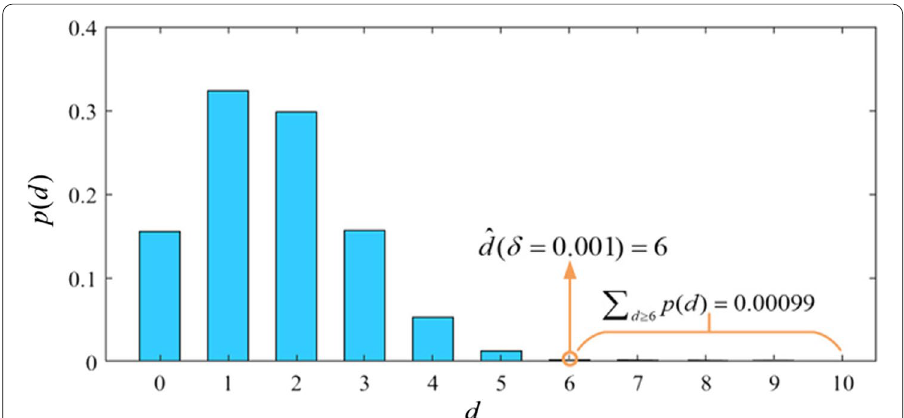
Fig. 3 Distribution of the accumulated following days via 500 groups of